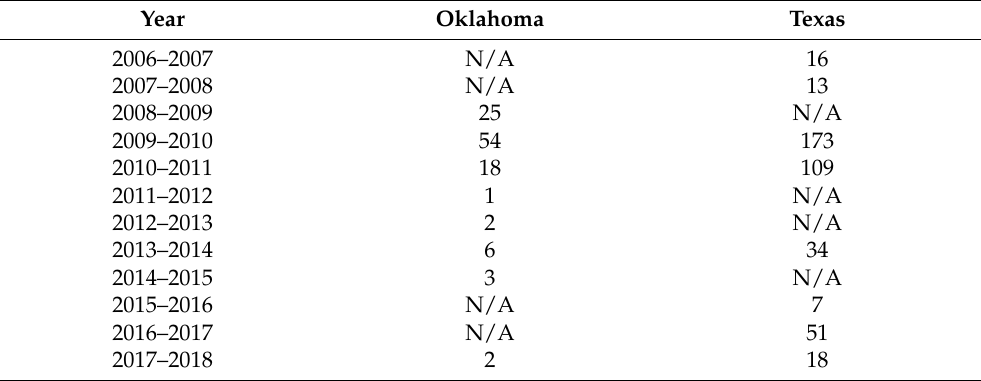
winter field season. N/A indicates that no efforts to find rails in Oklahoma occurred during that